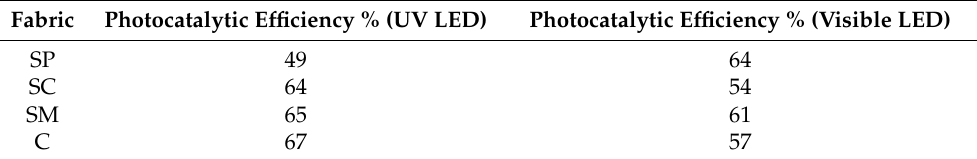
Table 5. Photocatalytic efficiency of different coated ceramicized tissues under UV and visible light irradiation. (Reprinted/adapted with permission from Ref.